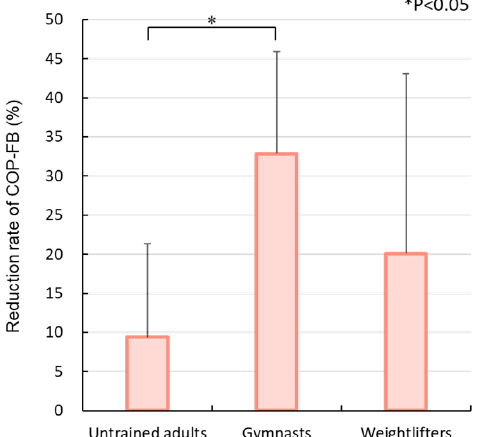
Figure 7. Comparison of the reduction rate of center of pressure displacement in the front-and-back direction (COP-FB) among participant groups when wearing a mouthguard. Measurements are expressed as means ± SD. Error bar indicates standard error of the mean. * p < 0.05: denotes statistically significant difference.